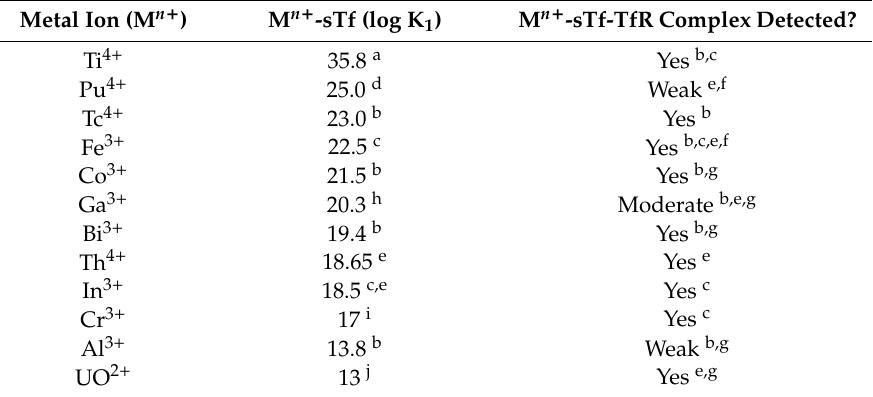
Table 1. M n + -sTf affinity and detection of M n + -sTf complexes with TfR.